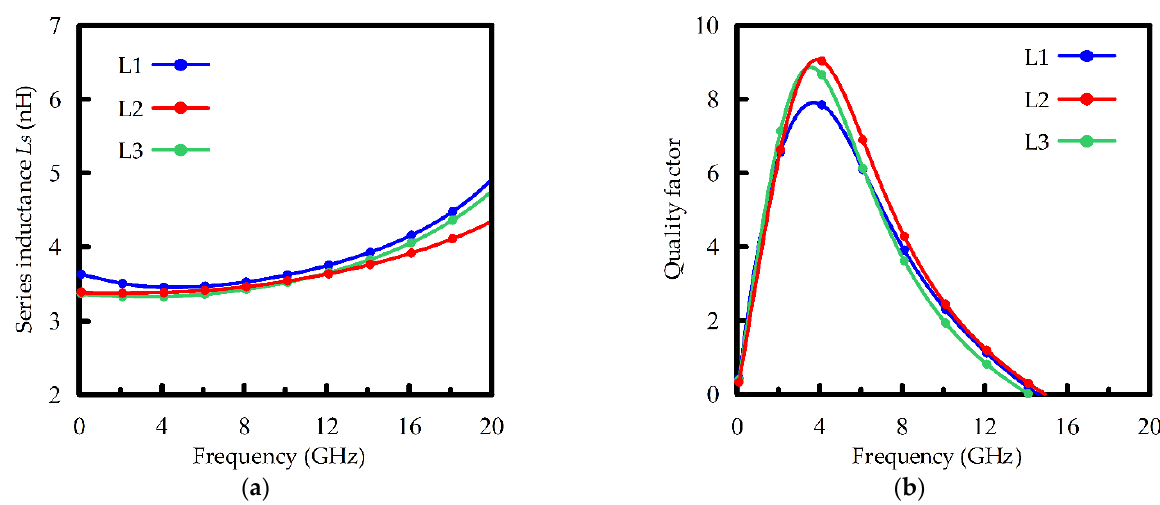
Figure 3. The simulated performances of inductors L1, L2, and L3. ( a ) The simulated series inductance L s ; ( b ) the simulated Q-factor.